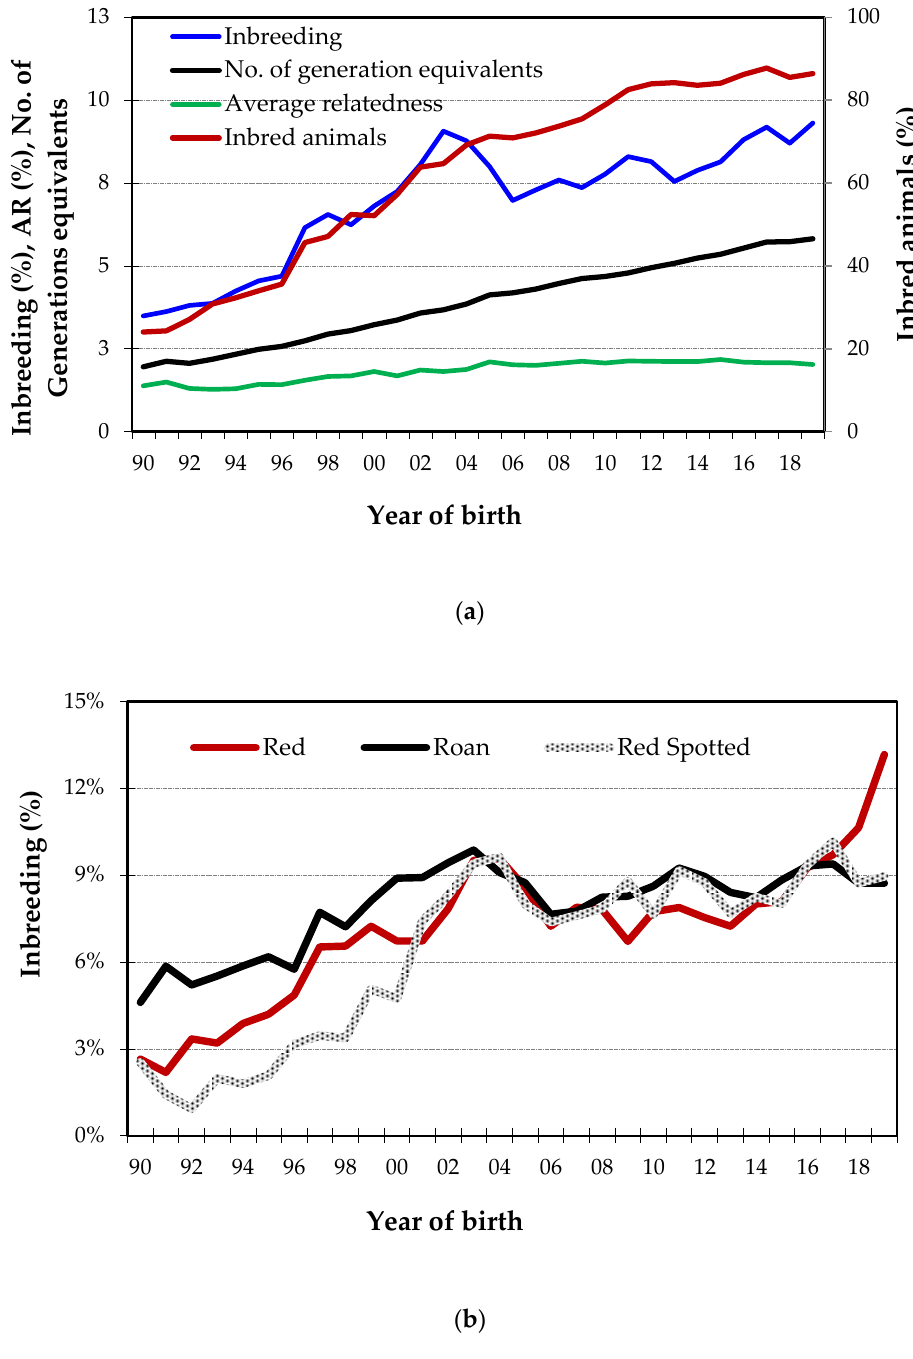
Figure 7. Average inbreeding per year of birth. ( a ) Average inbreeding, number of generations known, average relatedness and percentage of inbred animals. ( b ) Average inbreeding by variety (coat color) and year of birth.